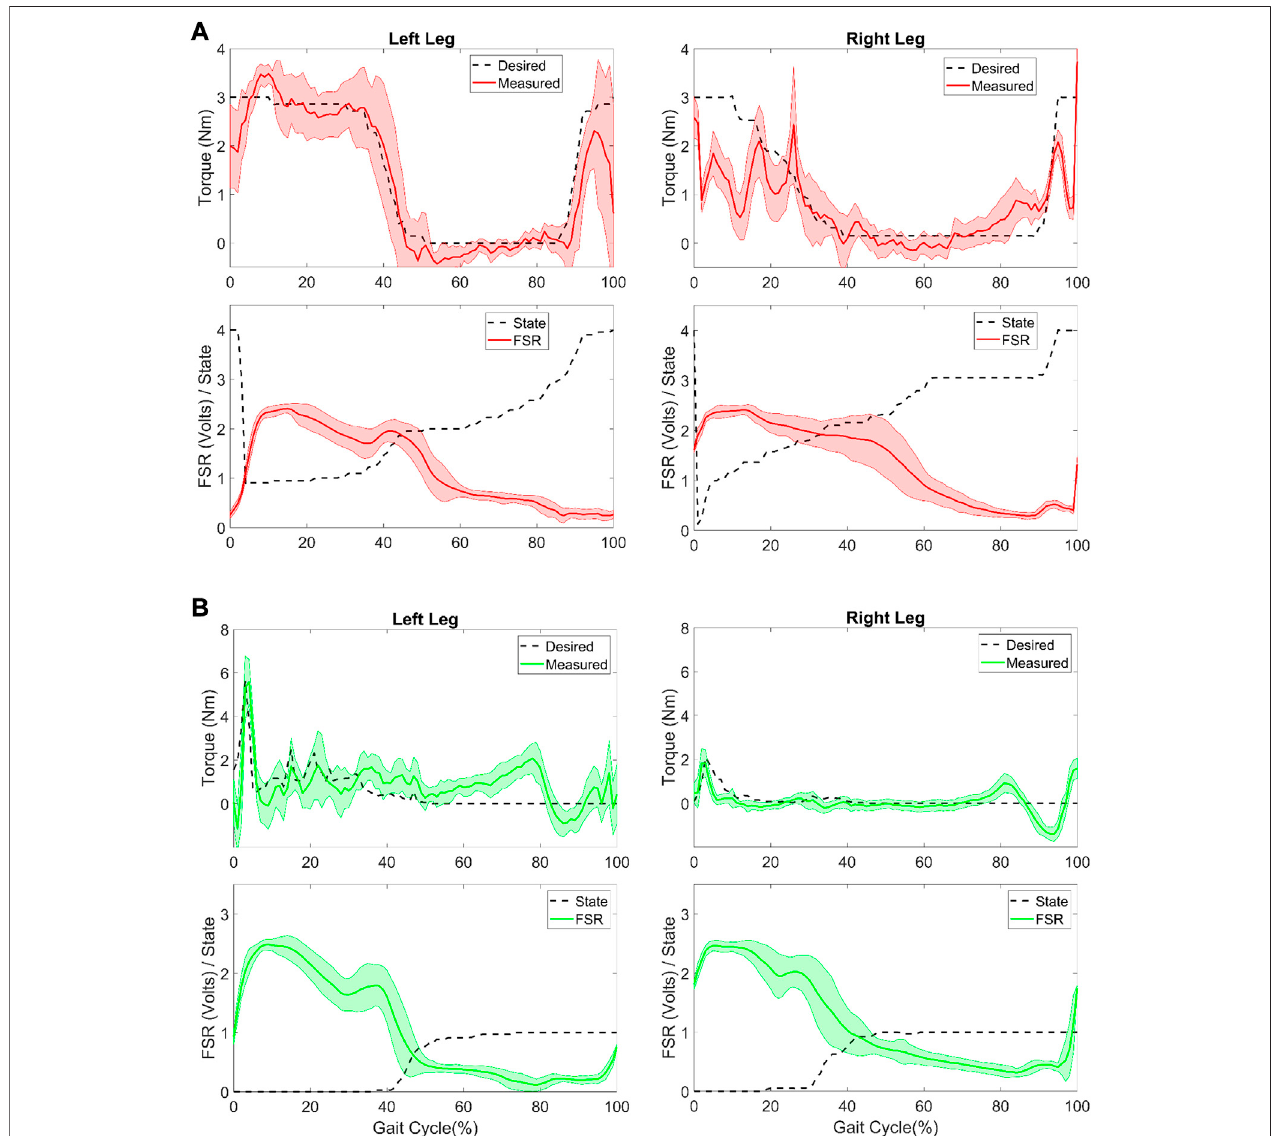
FIGURE 5 | Controller evaluation during overground walking in the participant with CP. (A) Desired and measured torque (top row) for the Constant mode (Est+MSt+Lsw) controller and the (bottom row) measured force sensitive resistor (FSR) and FSM state (0: early stance, 1: mid-stance, 2: late stance, 3: early swing, 4: late swing)fortheleftandrightleg. (B) Desiredand measured torque (toprow)fortheAdaptive controllerandthe(bottom row)measured FSRand FSMstate(0: stance, 1: swing) for the left and right leg.